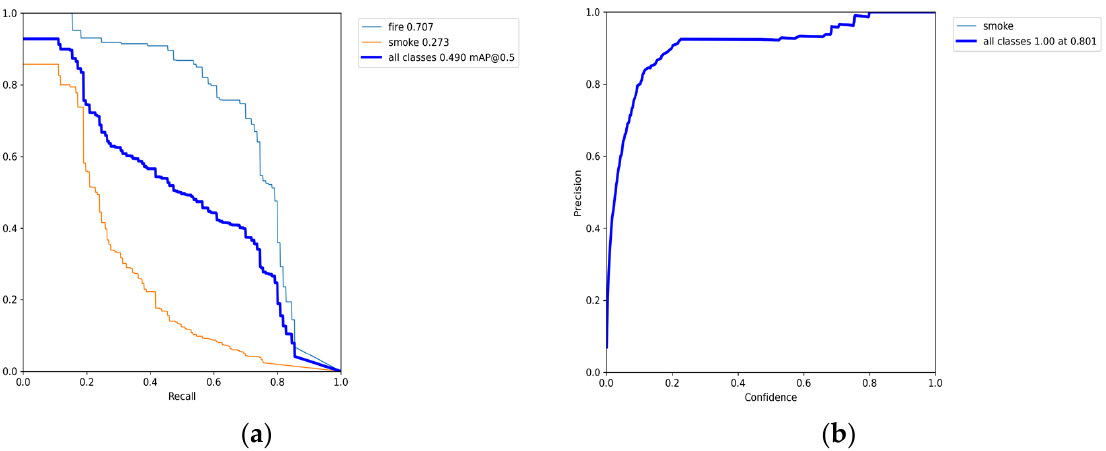
Figure 7. Model 1 and 2 precision evaluation: ( a ) first model, which is good at detecting fire; ( b ) smoke detection. According to the smoke and fire detector precision curve, the model jumps from 0.2 in the first model to 0.8. Table 4. Comparison of the combined detection architecture with the literature review. Best results are in bold.